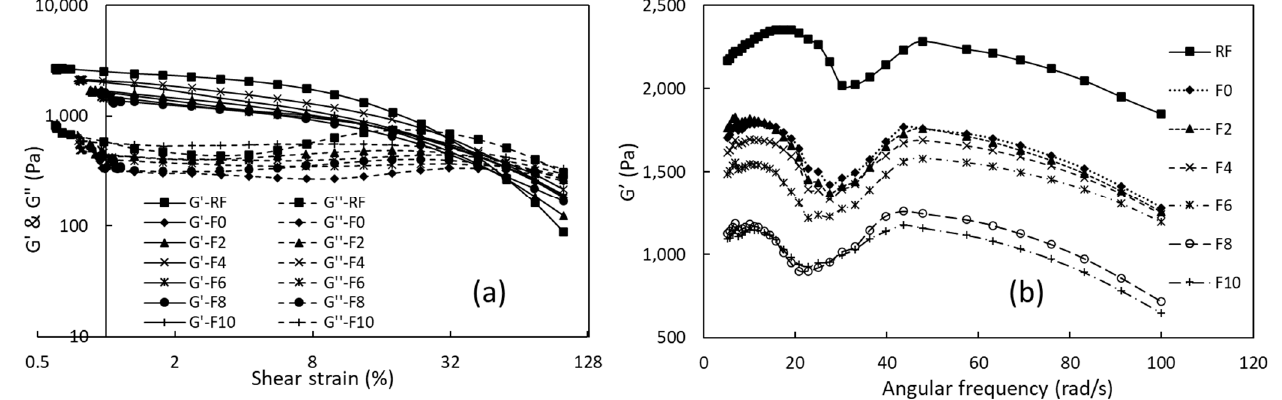
Figure 3. Dynamic rheology of gels of RF, F0, and FRN samples: ( a ) amplitude sweep test and ( b ) frequency sweep test. G ′ and G ″ are the storage and loss modulus, respectively. RF represents rice flour, F0 represents 0% MLP, F2 represents 2% MLP, F4 represents 4% MLP, F6 represents 6% MLP, F8 represents 8% MLP, and F10 represents 10% MLP.